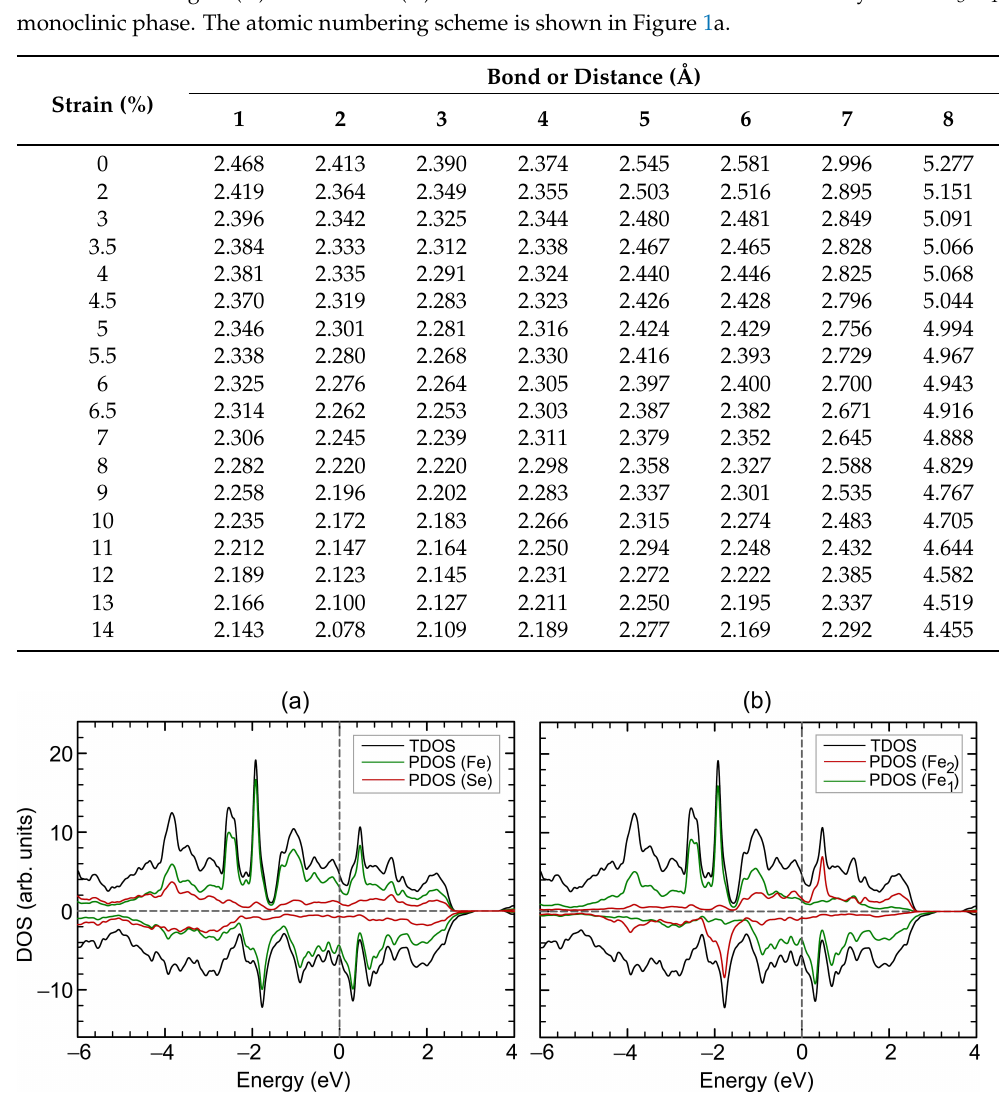
Figure 2. Density of states ( a , b ) of Fe 3 Se 4 . Total DOS of Fe 3 Se 4 is shown by black curves. In panel ( a ), partial DOS of Fe and Se atoms are shown by green and red curves, respectively. In panel ( b ), partial DOS of iron atoms on site 1 and on site 2 are shown by green and red curves, respectively. Positive and negative values of DOS corresponds to spin-up and spin-down channels, respectively. The Fermi level corresponds to